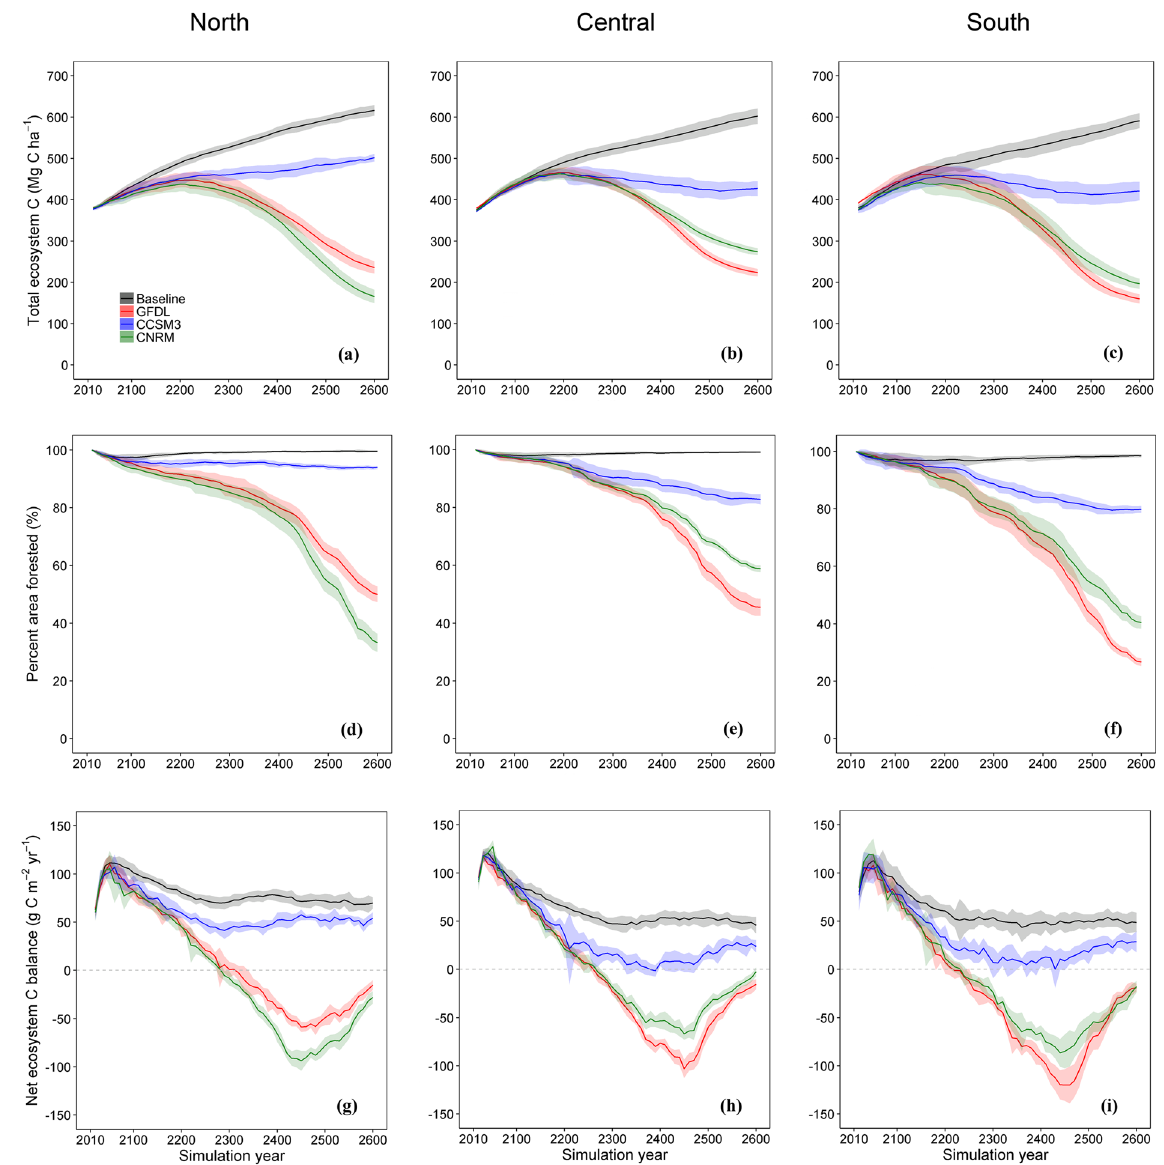
Figure 2. Changes in carbon stocks, fluxes, and forest cover. Mean total ecosystem C ( a–c ), percentage of area forested ( d–f ), and net ecosystem C balance ( g–i ) for baseline climate and wildfire and projected climate and wildfire scenarios under three general circulation models over the 590-year simulation period. The three column panels are for the three transects simulated in the northern, central, and southern Sierra Nevada. Shaded areas represent the standard deviations derived from replicate runs. See Supplementary Fig. 4 for spatial distribution of the